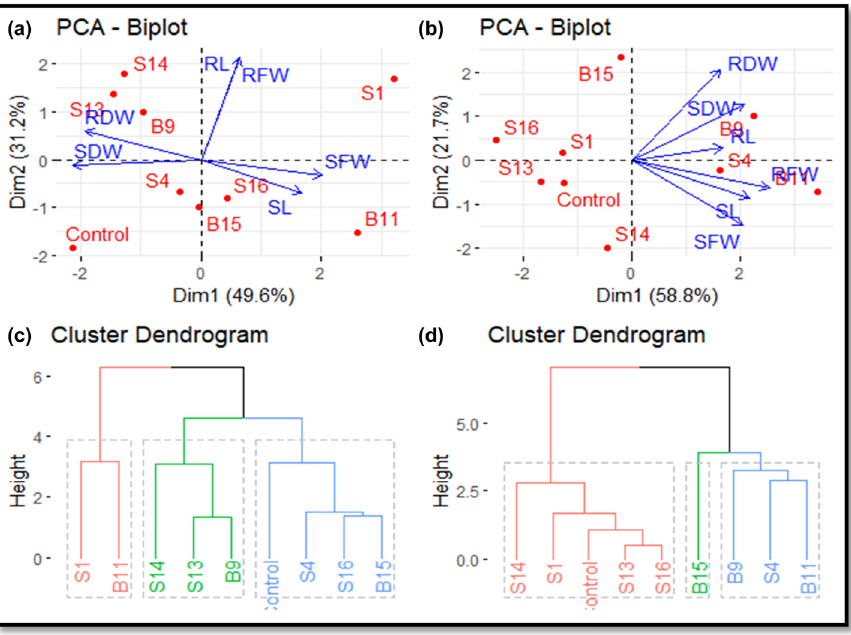
Figure 7: E ff ect of bacterial treatments on growth parameters of tomato seedlings on non - sterilized soil. ( a and b ) PCA of Raja ( a ) and Foolewouh ( b ) varieties. ( c and d ) HAC of individuals for Raja ( c ) and Foolewouh ( d ) varieties. SL – stem length; RL – root length; RFW – root fresh weight; RDW – root dry weight; SFW – stem fresh weight; RDW – root dry